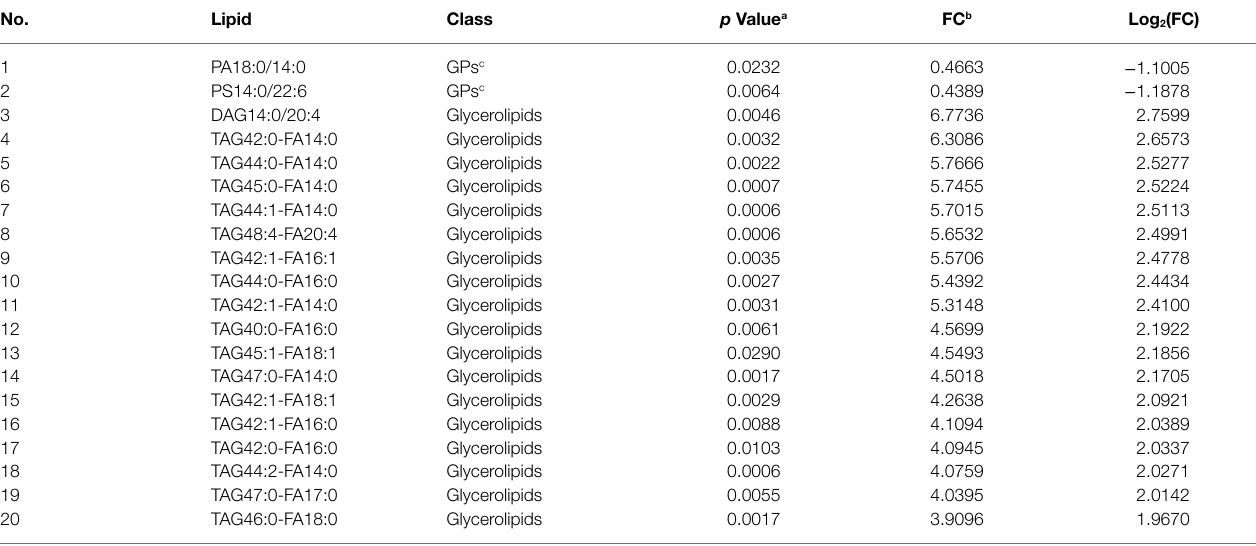
TABLE 5 | Top 20 lipids with different levels by presence of EBNA1-IgA among NPC patients. No. Lipid Class p Value a FC b Log 2 (FC)